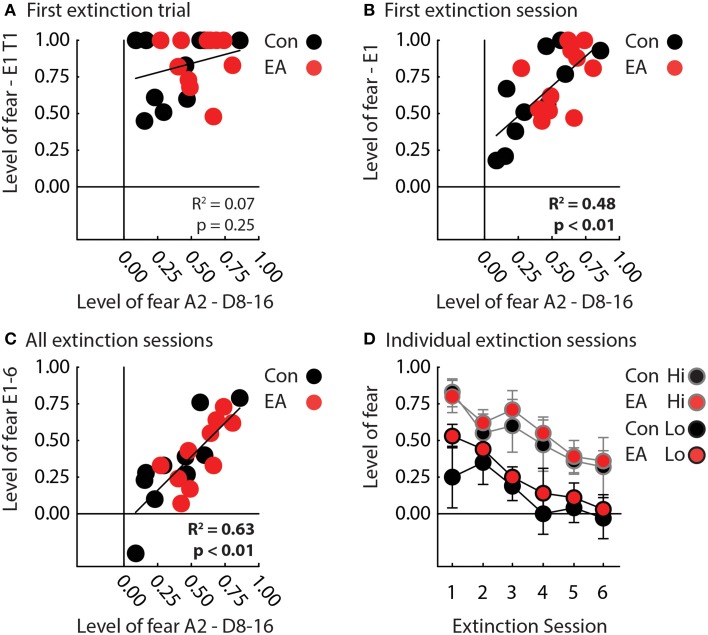
Fear in extinction. (A) A scatterplot compares mean nose poke suppression to the A2 cue during the final half of discrimination (x-axis) to mean nose poke suppression to the A1 cue on the first extinction trial for Control (black) and EA rats (red). There was zero correlation between the two measures across all rats (R2 = 0.07, p = 0.25). (B) A scatterplot compares mean nose poke suppression to the A2 cue over the final half of discrimination (x-axis) to mean nose poke suppression to A1 during the first extinction session for Control (black) and EA rats (red). There was a significant, positive correlation between the two measures across all rats (R2 = 0.48, p < 0.01). (C) A scatterplot compares mean nose poke suppression to A2 over the final half of discrimination (x-axis) to mean nose poke suppression to A1 over all extinction sessions for Control (black) and EA rats (red). There was a significant, positive correlation between the two measures across all rats (R2 = 0.63, p < 0.01). Note that one Control rat achieved a negative suppression ratio, indicating he increased, rather than suppressed, nose poking during the cue in extinction. (D) Mean nose poke suppression to A1 (y-axis) over the six sessions of extinction is plotted for Control (black fill) and EA rats (red fill) that showed Lo (black outline) or Hi (gray outline) fear to the uncertain A2 cue in the final half of discrimination (individual data taken from Figure 2C). “Lo” rats were the half of each group (Control, n = 5; EA, n = 5) showing the lowest levels of fear to the probabilistic cue in discrimination. “Hi” rats were the half of each group (Control, n = 5; EA, n = 5) showing the highest levels of fear. Rats were separated into “Lo” and “Hi” for illustrative purposes only. ANCOVA was performed with the level of fear to the probabilistic cue as a covariate.